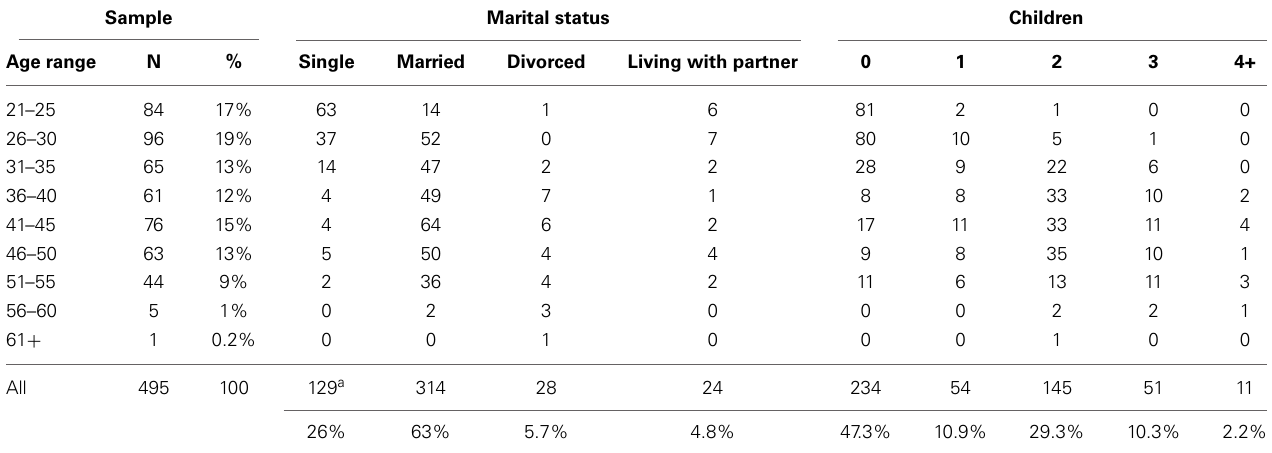
Table 4 | Marital status and number of children for women with engineering